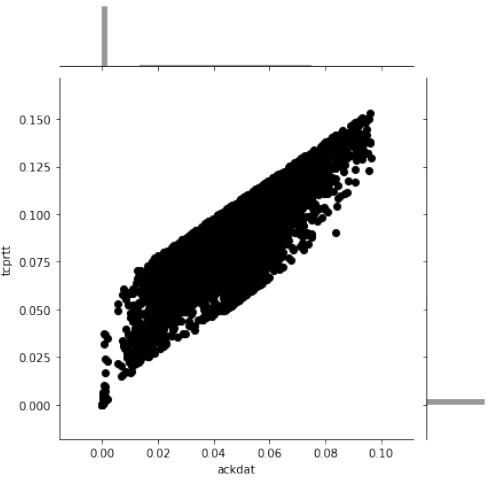
Fig 5. Point plots for all the relevant features in the dataset